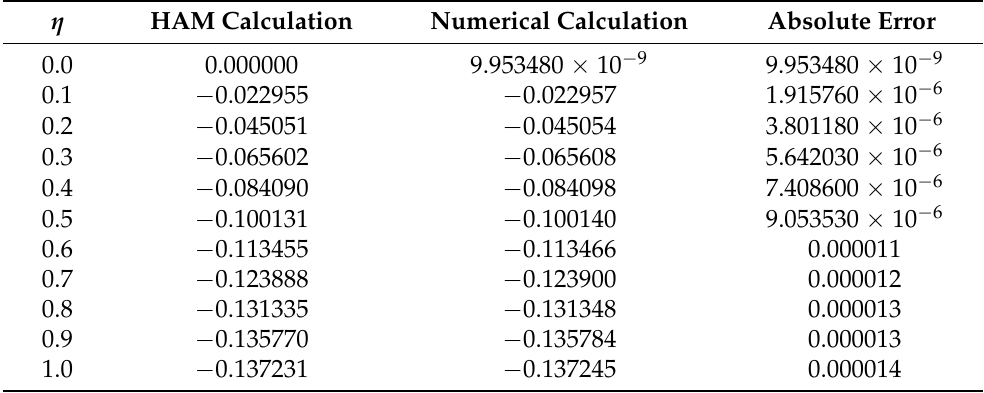
Table 4. Comparison between the analytical (HAM) and numerical results S ( η ) .